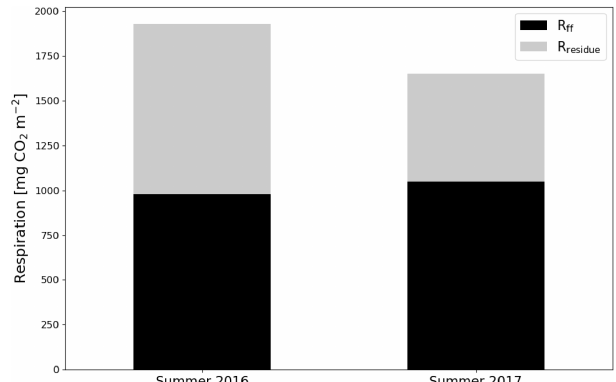
Figure 9. The division of ecosystem respiration ( R eco , based on EC measurements) to forest floor respiration R ff (chamber measure- ments) and respiration of logging residues ( R residue = R eco − R ff ) for the summers of 2016 and